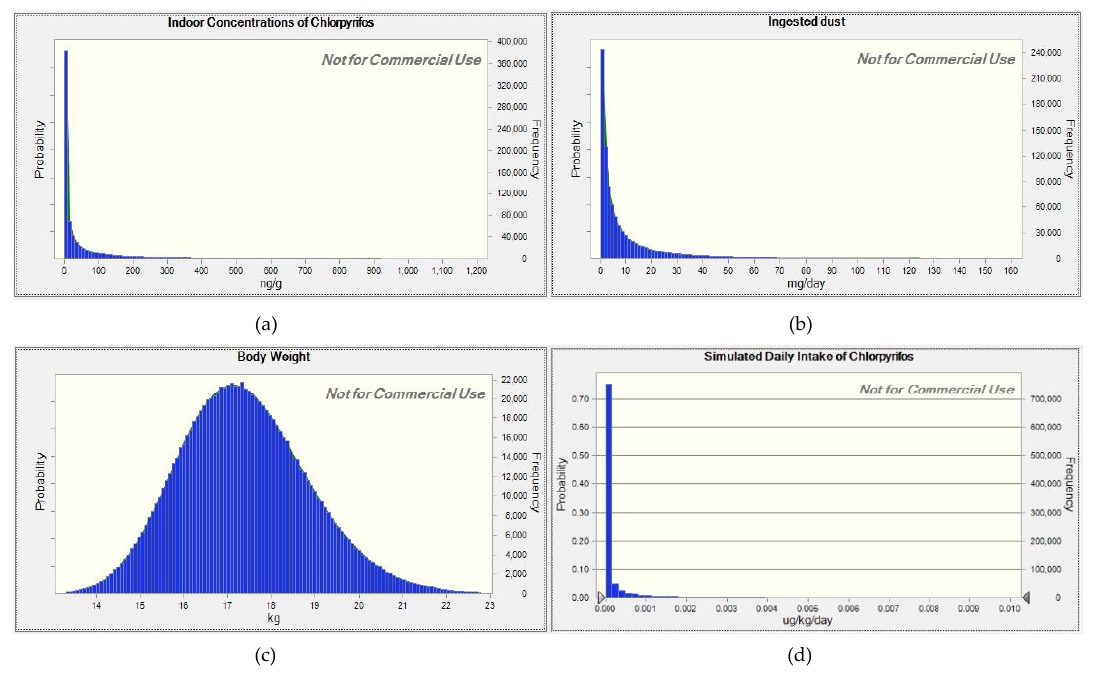
Figure 1. Distributions of variables ( a – c ), and result ( d ) for estimation of daily intake of chlorpyrifos.